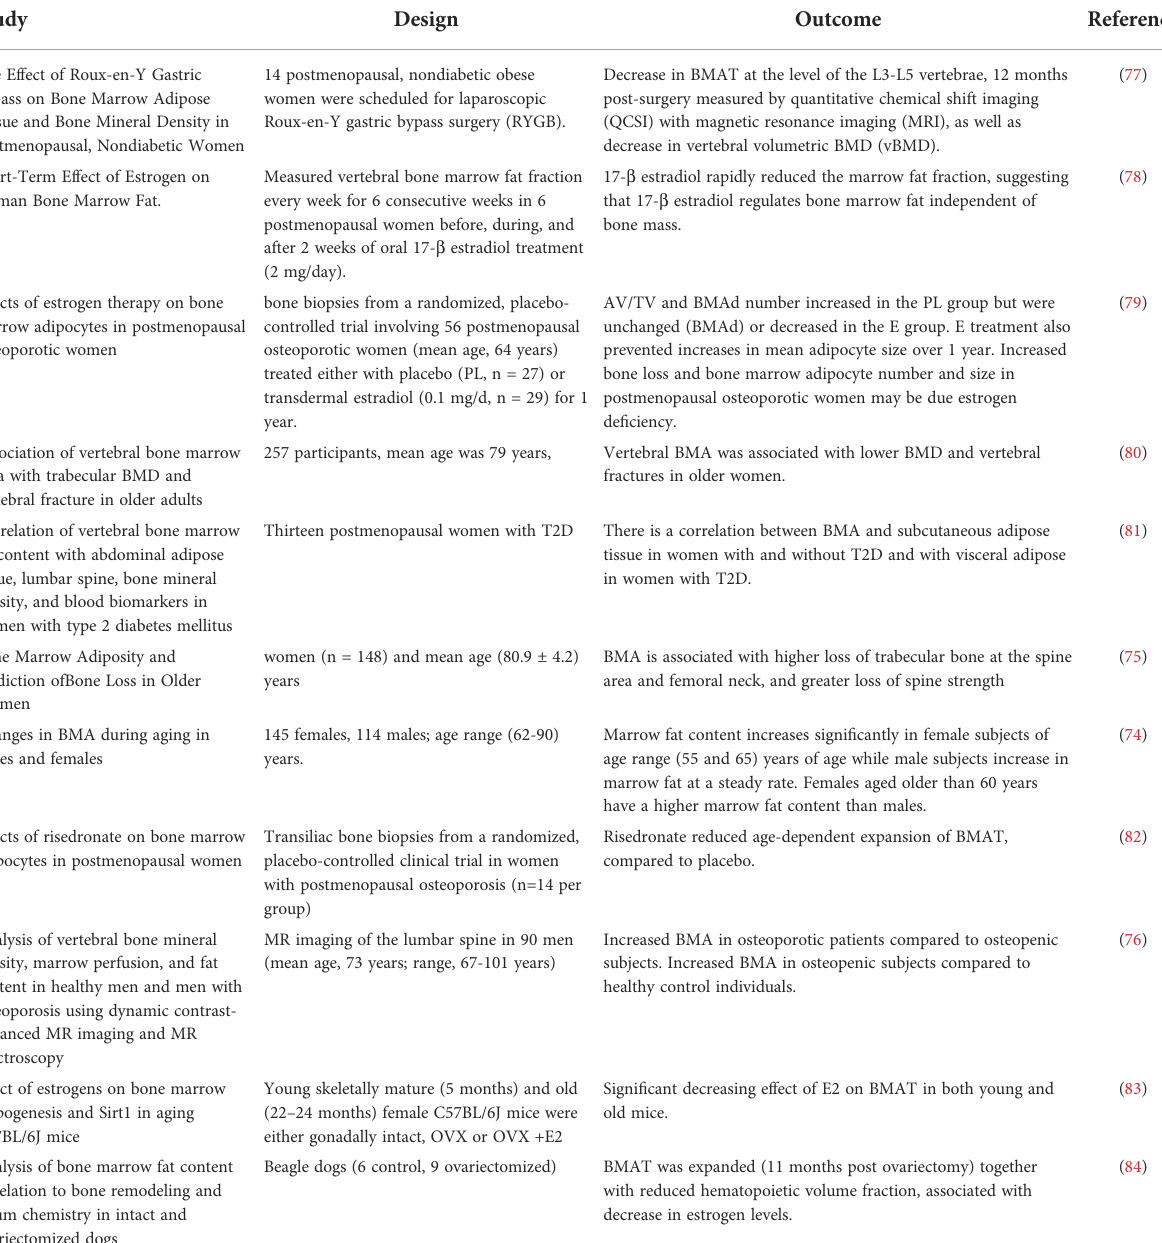
TABLE 1 Summary of several clinical and preclinical studies related to investigating the association of endocrine aging and BMAT expansion .